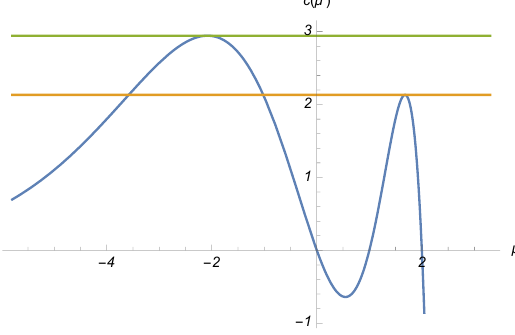
Figure 1. Graph of c ( µ ) for α = γ = 0 and τ =